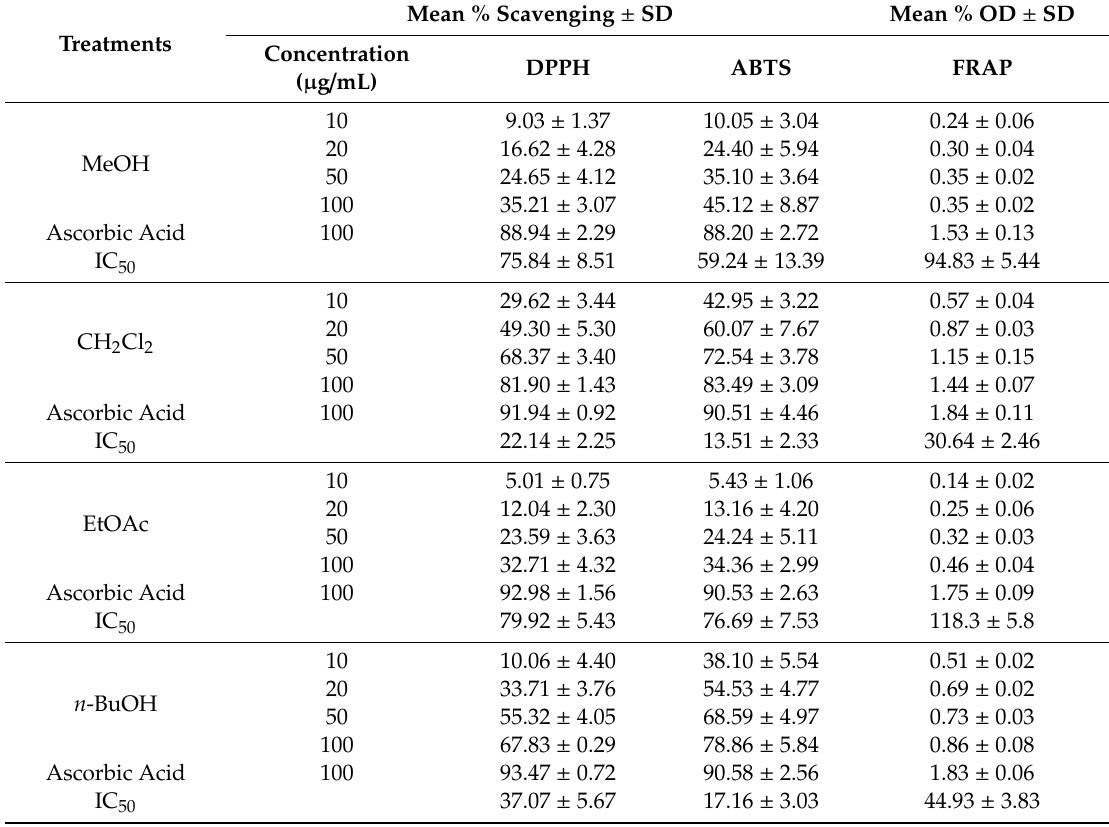
Table 3. Antioxidant e ff ects of A. vacillans extracts in DPPH, ABT, and FRAP assays.